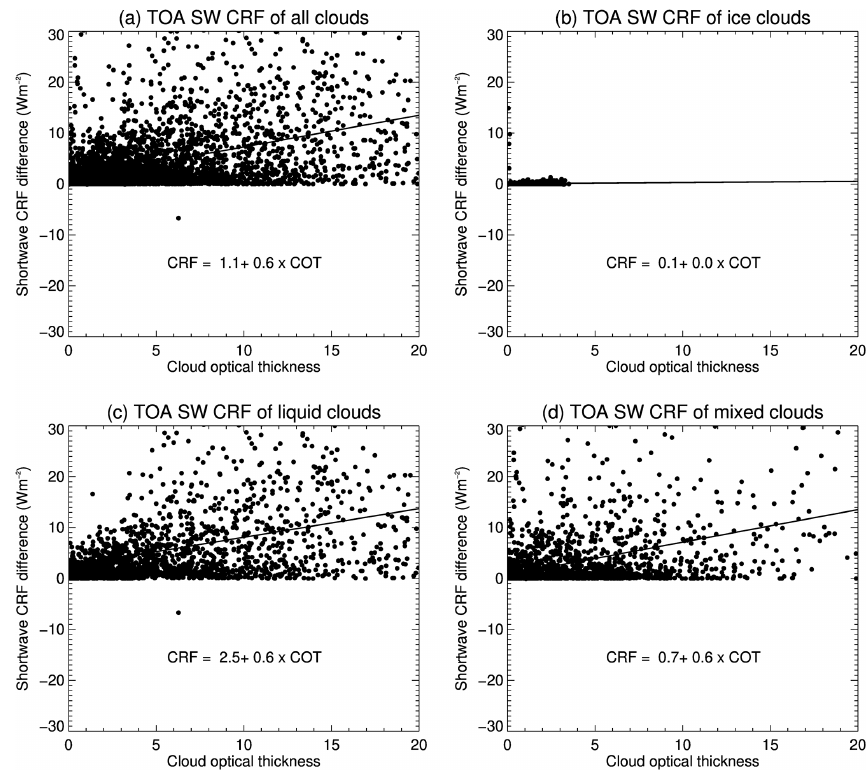
Figure 17. Scatterplots of shortwave cloud radiative forcing at the TOA between using clouds from surface observations and clouds identified by combined CloudSat and CALIPSO and cloud optical thickness of omitted (a) all clouds, (b) ice clouds, (c) liquid clouds, and (d) mixed- phase clouds below 1km during the SHEBA